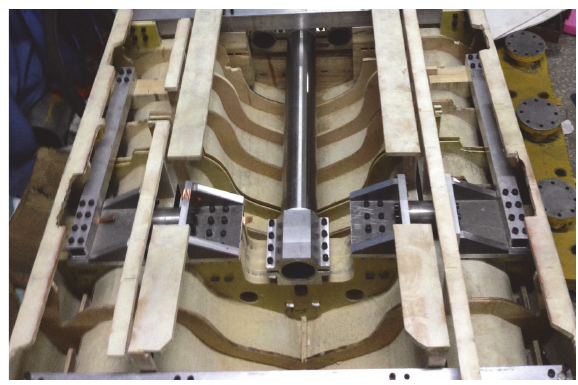
Figure 1: Trimaran backbone systems design.